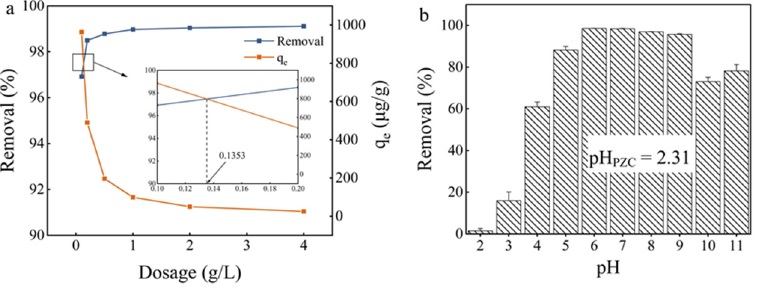
Figure 4. ( a ) Effect of adsorbent dosage; ( b ) the solution pH on Cd (II) adsorption onto the synthe- sized Fe 3 O 4 @PB. sized Fe 3 O 4